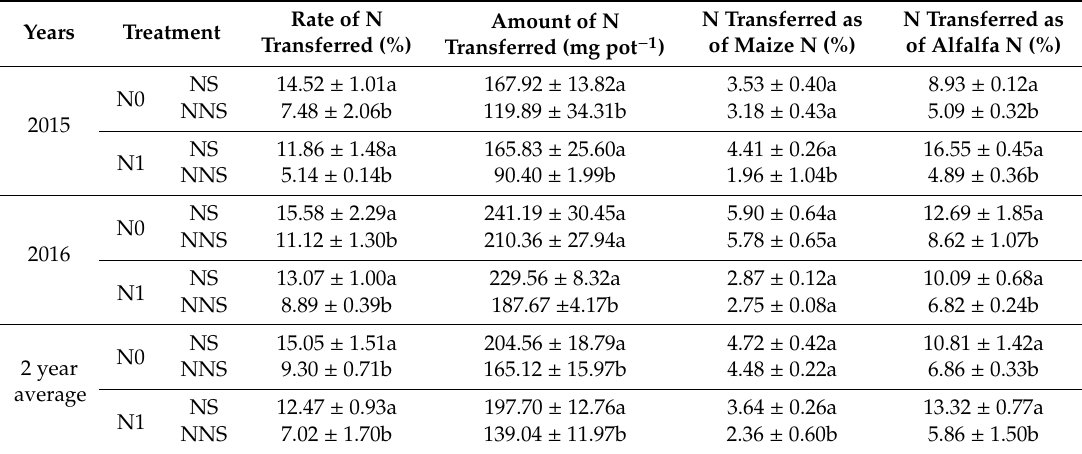
Table 5. Nitrogen transferred from 15 N-labeled plants to intercropped plants under di ff erent experimental